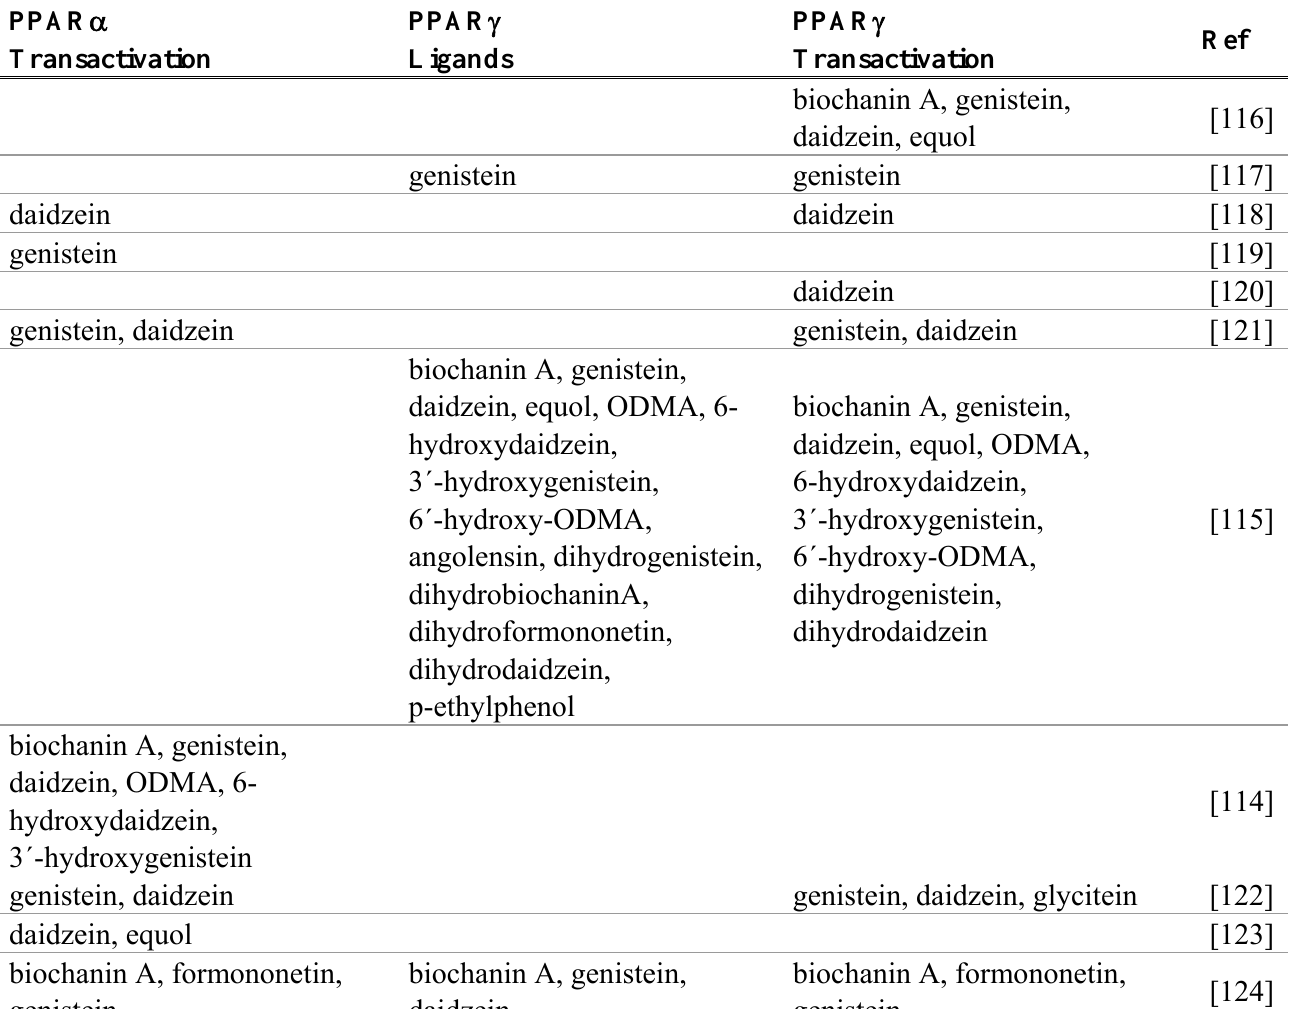
Table 1. The isoflavones as PPAR  and PPAR  ligands or